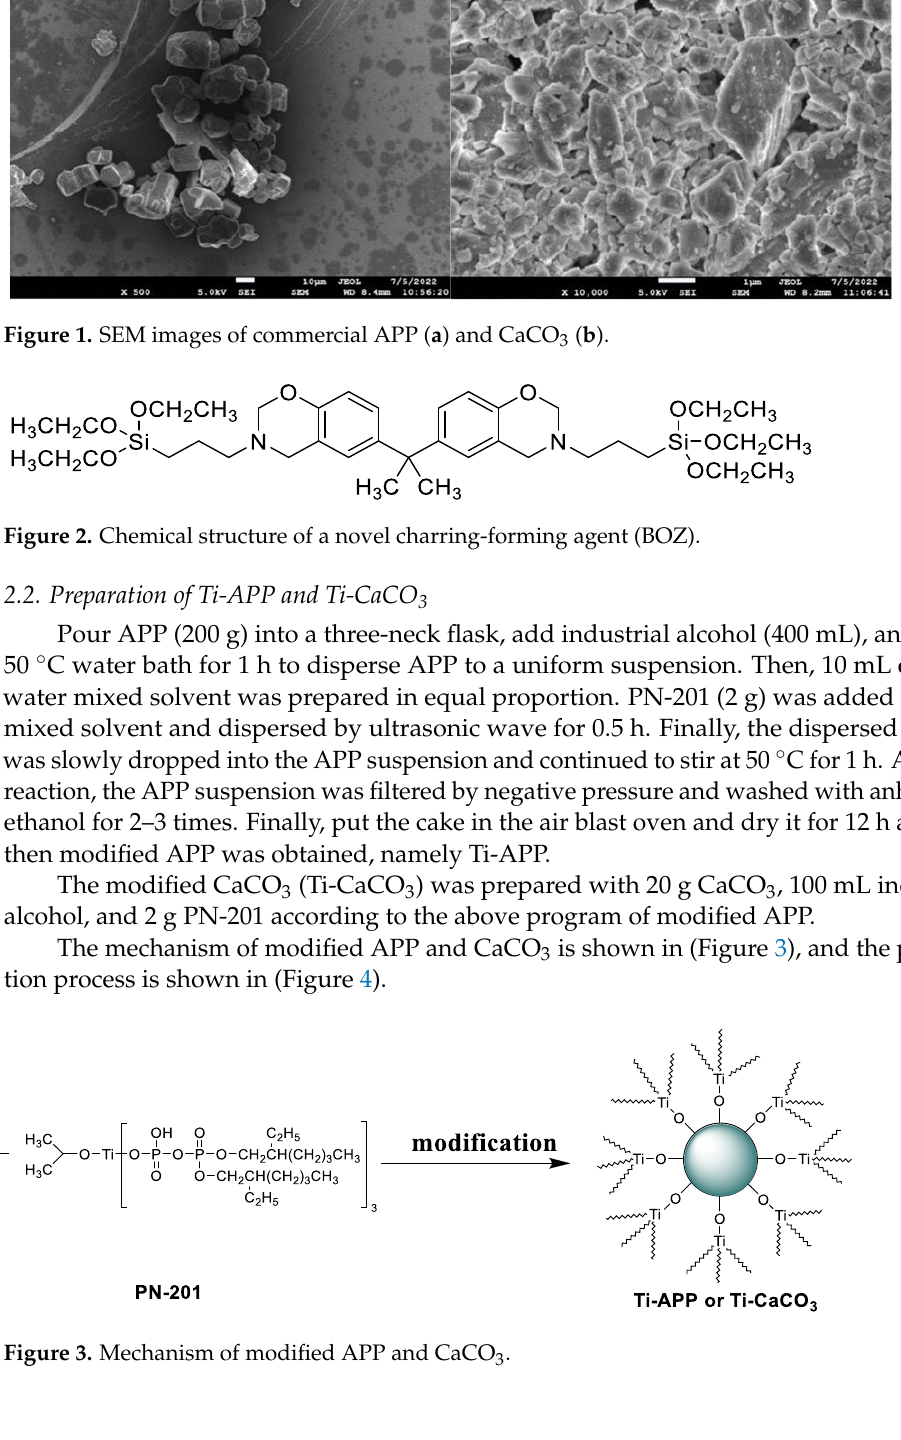
Figure 4. Schematic diagram of the preparation process of modified APP and CaCO 3. 2.3. Preparation of FR-POM Composites The IFR consists of APP, BOZ, and ME in the mass ratio of 10:2:3 in line with our previous optimization results. Here, Ti-APP is compounded with BOZ and ME at the same mass ratio to form a new intumescent flame retardant named as Ti-IFR instead of IFR. Additionally, the total amount of additives was kept at 30 wt%. According to the formula in Table 1, POM and a certain proportion of the flame- retardant additives are uniformly mixed in a high-speed mixer and then put into an ex- truder for melt blending and granulation. The melting temperature of POM was main- tained at 165 – 175 °C. The pellets were placed in a blast drying oven and dried at 80 °C until moisture-free. Finally, the fully dried pellets were put into the injection molding ma- chine for standard test specimens. Table 1. Formulation and nomenclature of flame-retardant composites. Sample Codes